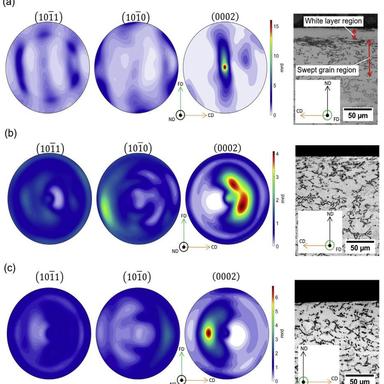
ODF pole figures and corresponding micrographs: (a) machined sample 7 containing a white layer of up to 20 μm in thickness, (b) a sample from trial 6 where the white layer has been removed to leave only the swept grain material and (c) a sample from trial 4 where no white layer was present. FD=feed direction, CD=cutting direction, ND=normal direction.